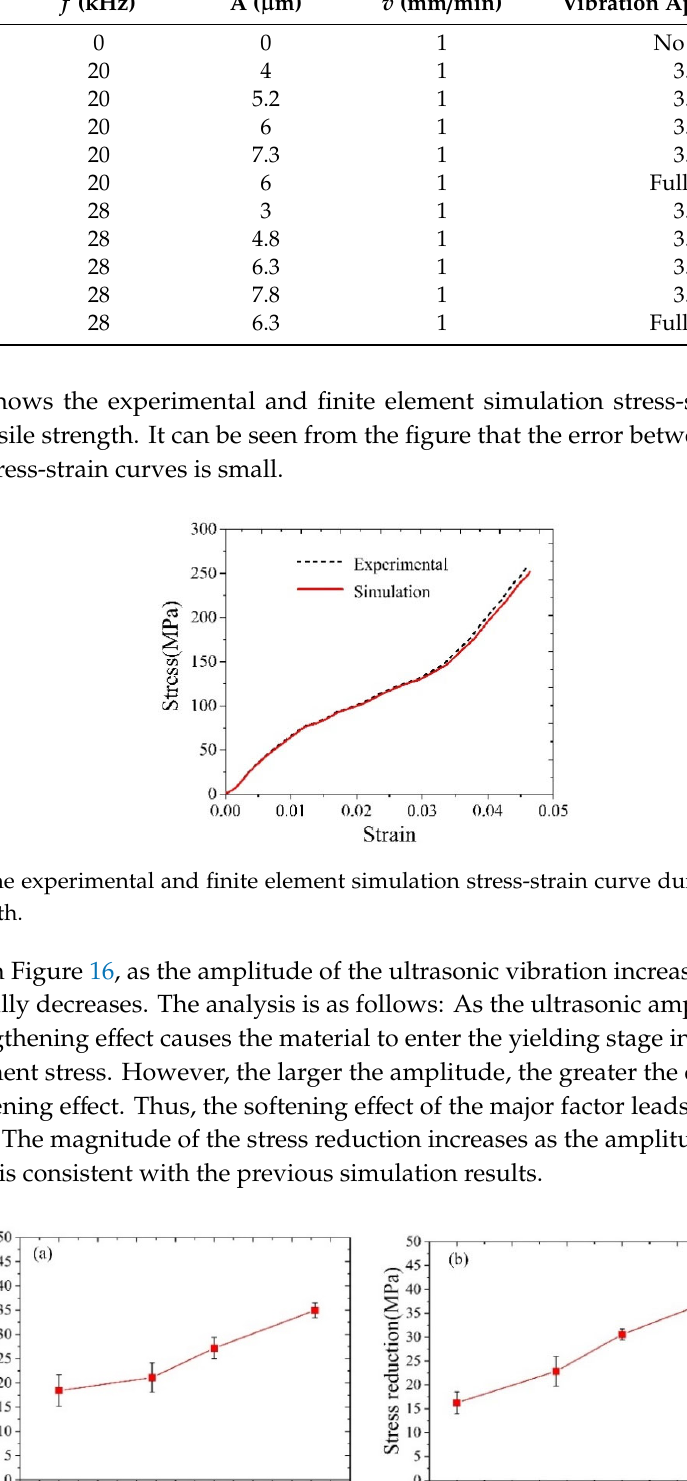
Figure 16. The magnitude of the stress reduction under different amplitudes of ultrasonic vibration: ( a ) 20 kHz, and ( b ) 28 KHz.